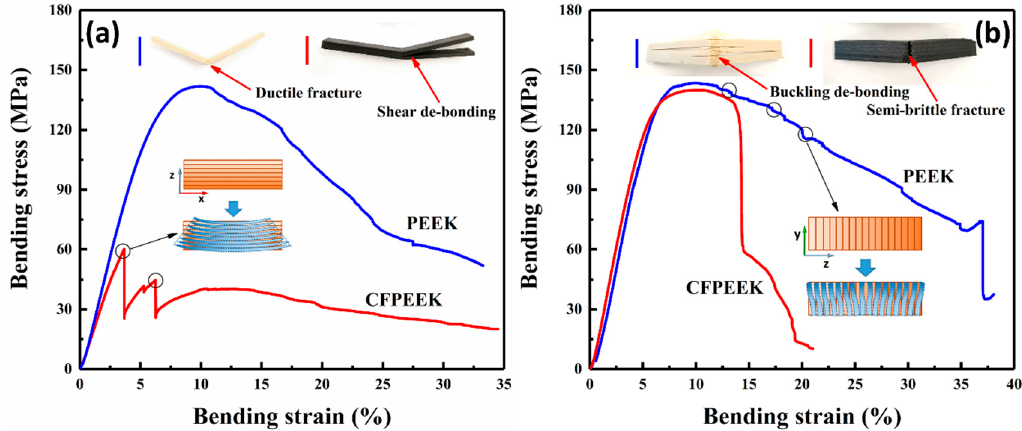
Figure 5. Bending fracture modes of ( a ) horizontally printed specimens, ( b ) vertically printed specimens.